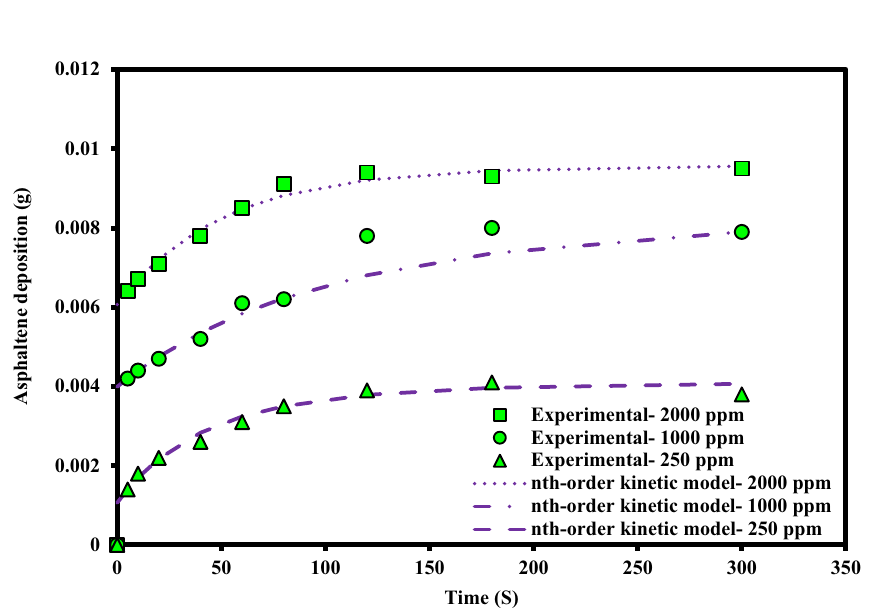
Figure 15. Agreement of the nth-Order deposition kinetic model to experimental data for different concentrations at static state for PTFE